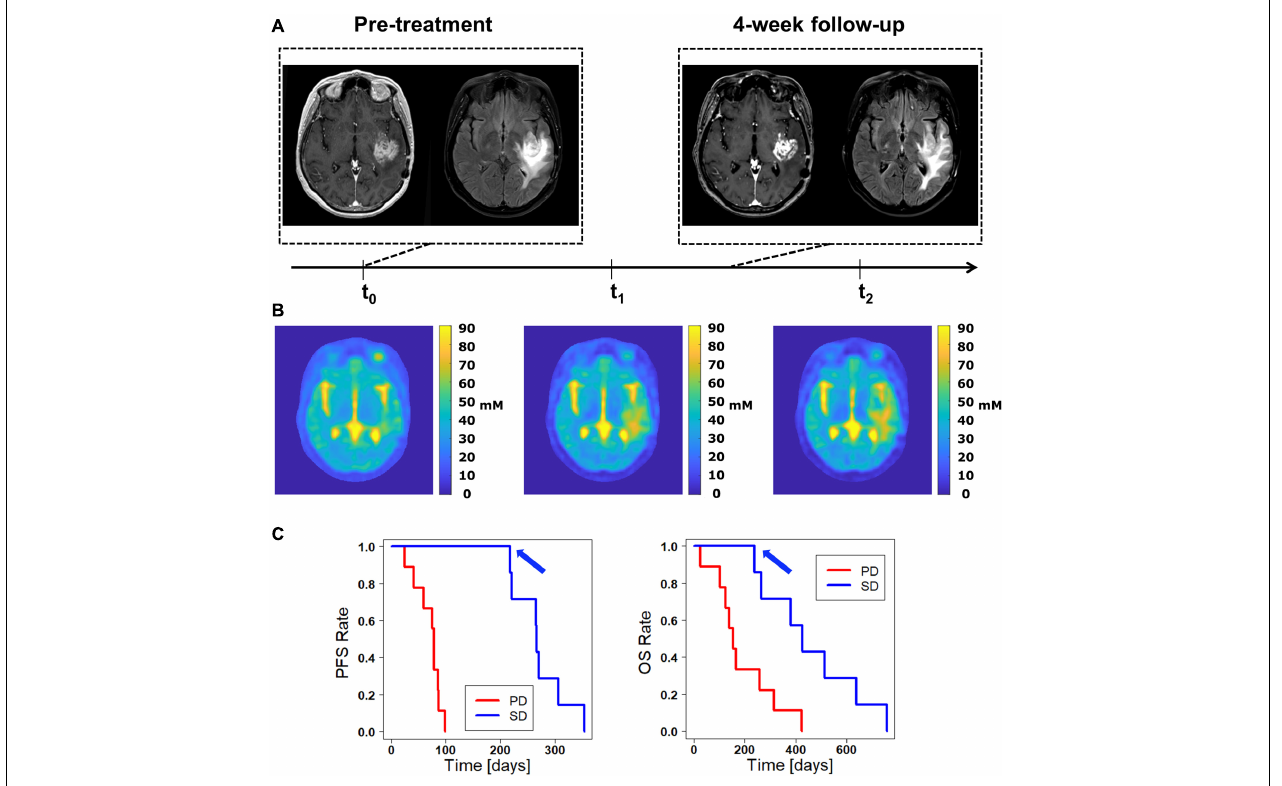
FIGURE 2 | Discrepancy between clinical 3T MRI and 7T 23 Na MRI. (A) The clinical 3T MRI of this patient presents only minor changes when comparing the pre-therapy baseline with the 4-week follow up, suggesting an initial stable disease (SD) according to the RANO criteria. (B) The tissue sodium concentration (TSC) shows a successive signal increase both inside the contrast enhancing region and within peritumoral edema. One could deduce a progressive disease (PD) with additional tumor infiltration and consecutively increased signal. On the other hand, a treatment response with successive tumor necrosis and reactive perifocal edema would also be a possible explanation. (C) The Kaplan-Meier curves for progression free survival (PFS, left) and overall survival (OS, right) show the significant prediction of PFS and OS by the RANO classification found in this study. Accordingly, the patient shown in A and B, which is rated as initial SD, lies on the favorable upper curve (blue